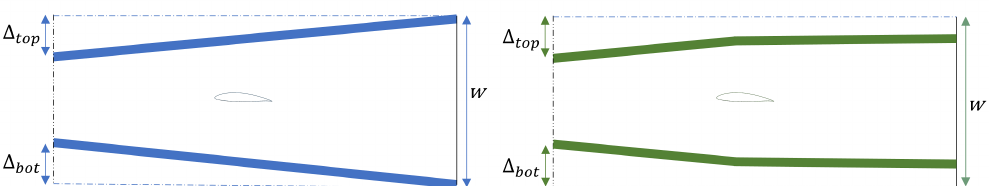
Figure 12. Schematic representation of two insert configurations: ( left ) completely diverging, and ( right ) half diverging with the breaking point at x / C =